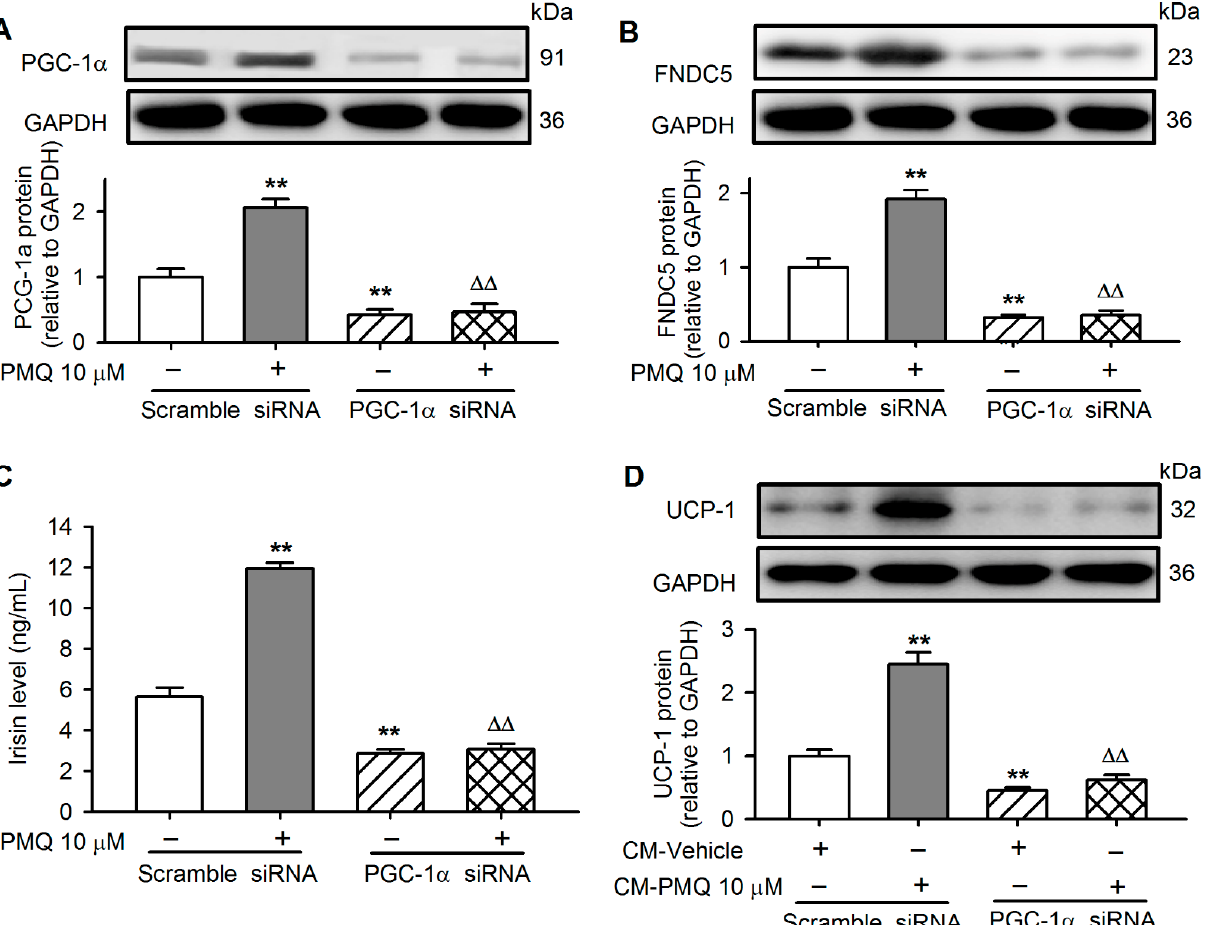
Figure 6. Down-regulation of PGC-1 α blocks the stimulatory effects of conditioned medium from PMQ-treated myotubes on UCP-1 expression in 3T3-L1 adipocytes. ( A , B ) C2C12 cells were transfected with siRNA-scramble or siRNA-PGC-1 α , exposed to DMSO or PMQ 10 μ M for 16 h, the protein levels of PGC-1 α and FNDC5 in C2C12 cells were quantified by western blot. ( C ) After C2C12 cells were transfected with siRNA-scramble or siRNA-PGC-1 α and PMQ incubation, and then cultured with regular DMEM for an additional 24 h, the irisin concentration in CM was detected. ( D ) UCP-1 protein levels in 3T3-L1 cells incubated with conditioned medium from C2C12 cells. ** p < 0.01 vs scramble siRNA without PMQ; ΔΔ p < 0.01 vs scramble siRNA with PMQ. Data are expressed as means ± SEM. n = 3–6.